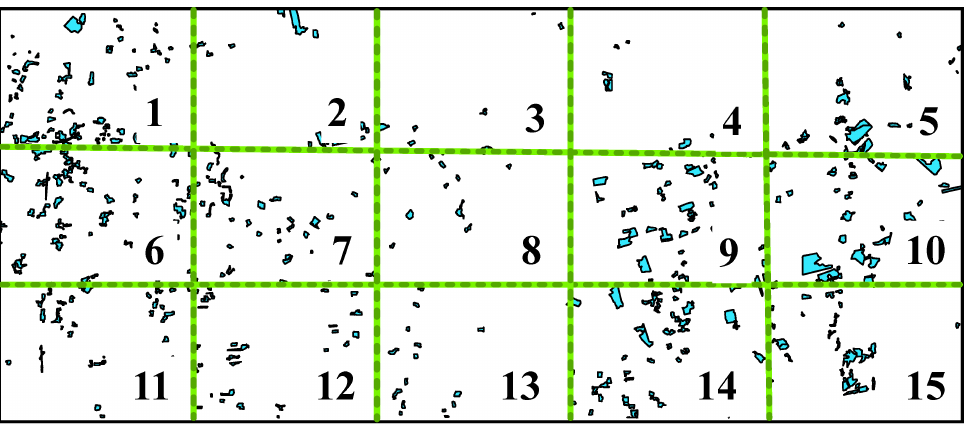
Figure 3. Image tiles (numbered) and deforestation polygons (source: